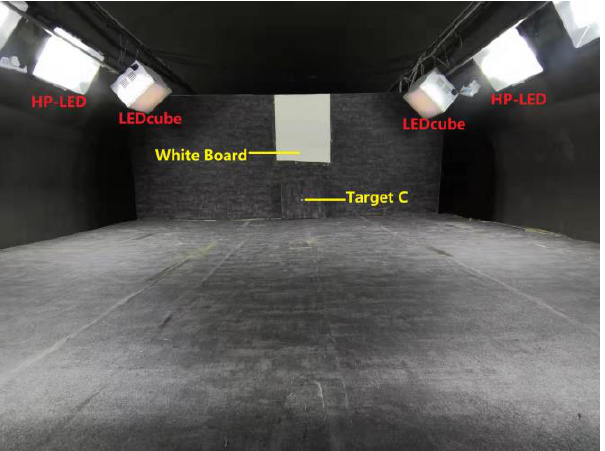
Figure 8. The real experiment situation. Target C refers to the Landolt chart applied in the experiment.